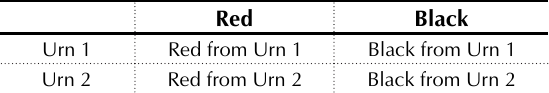
Table 1. Contingency table of